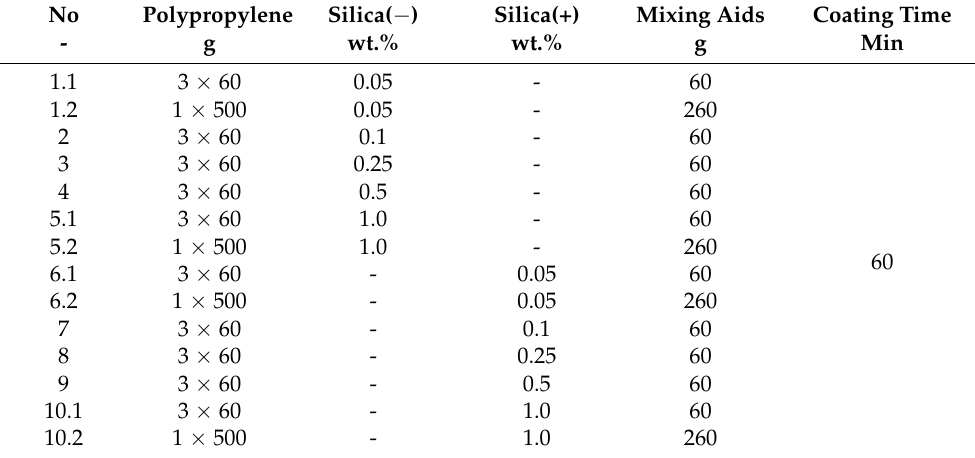
Table 2. Plan of deposition